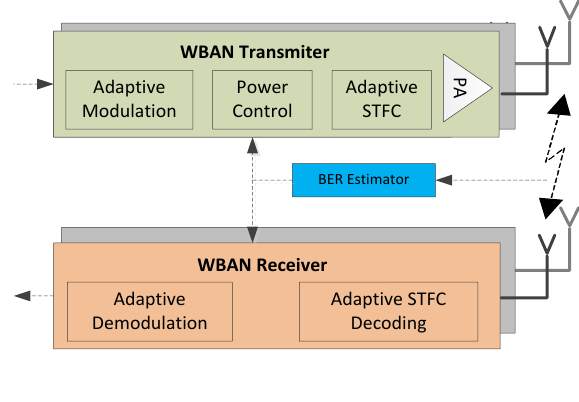
Figure 2 . Adaptive WBAN